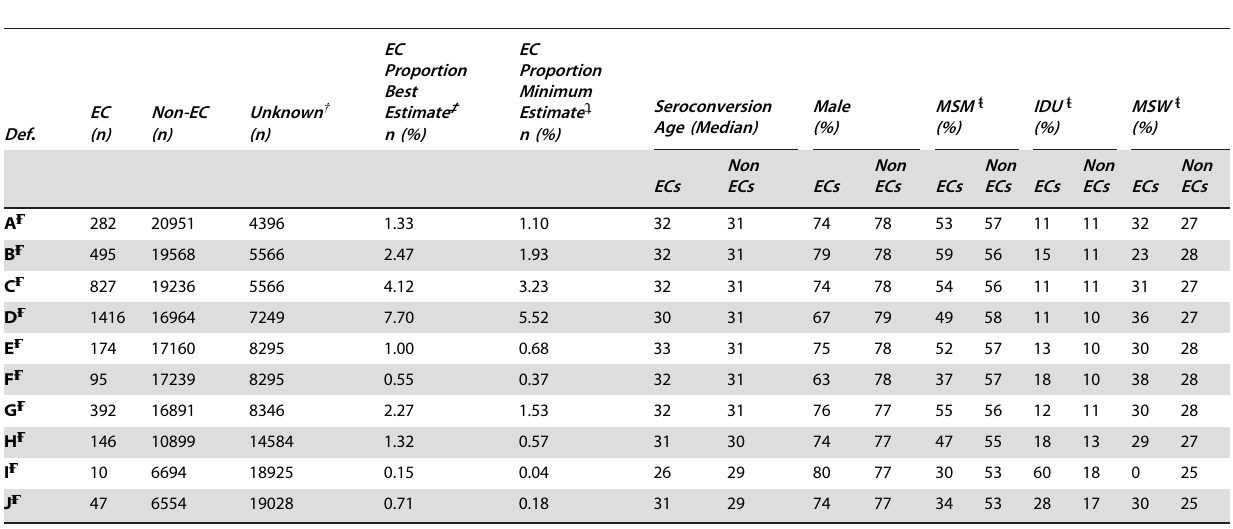
Table 2. Number of elite controllers (EC), their proportion, and demographic characteristics applying the CASCADE dataset to 10 definitions of EC found in the